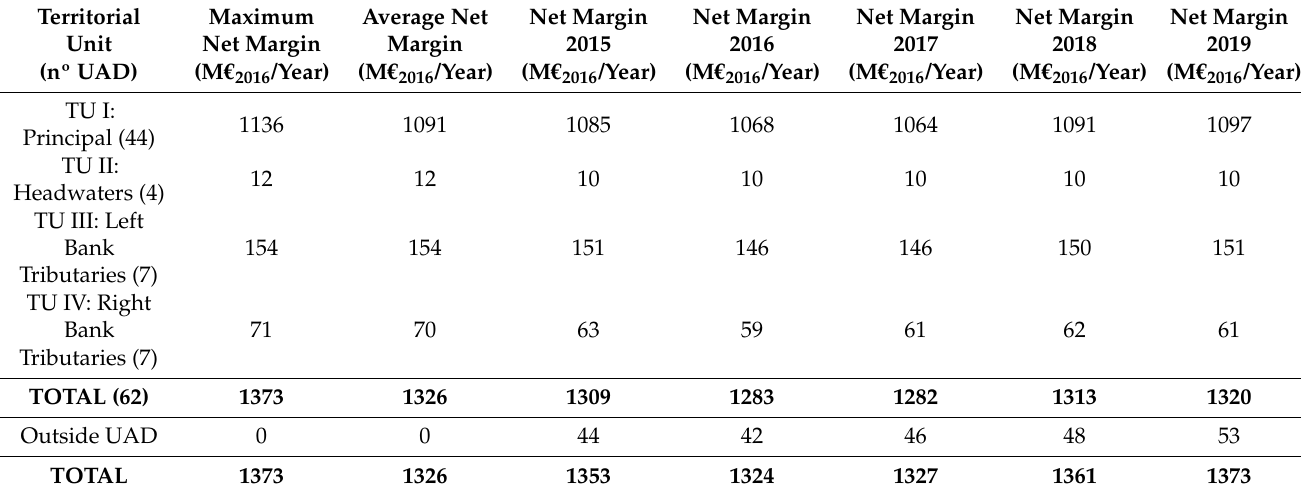
Table 19. Evolution of net margin 2015–2019. Source: [42] based on